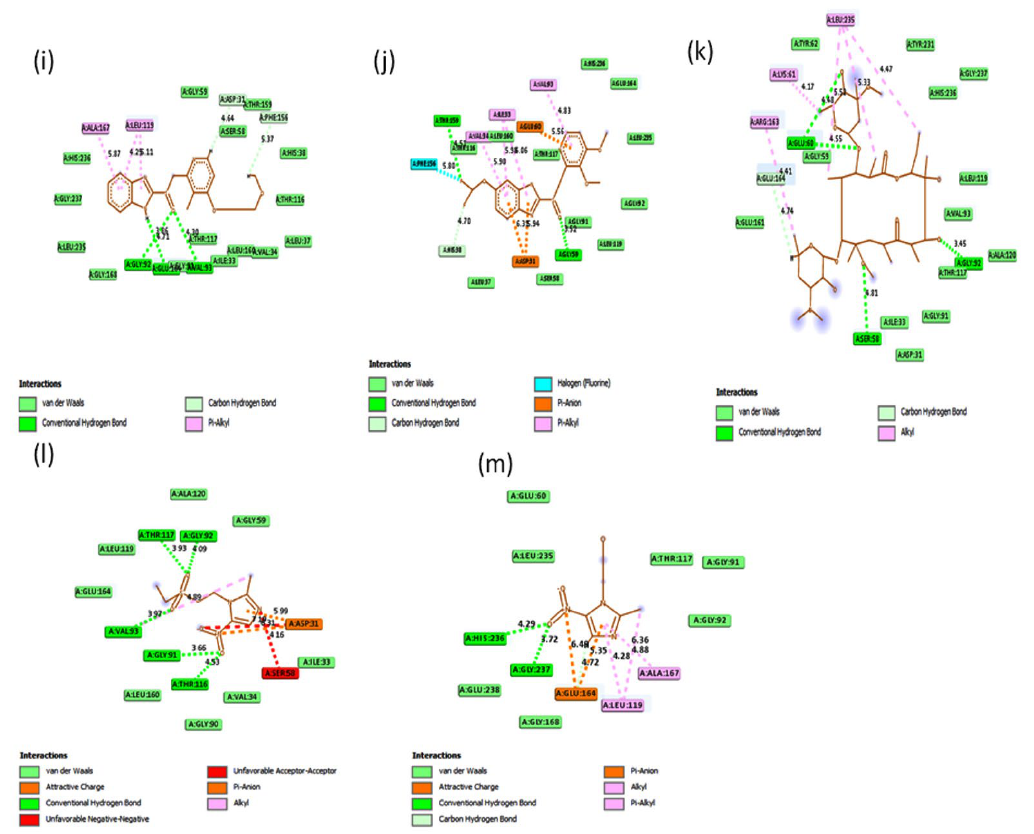
Fig. 2C. 2D interactions of compounds RBP, PPZ, CLA, TIND, and MTZ with chorismate synthase PDB: 1UFM. 2D structures of the candidate drugs (i) Rabeprazole (RBP) (j). Pantoprazole (PPZ). (k) Clarithromycin (CLA). (l) Tinadazole (TIND). (m) Metronidazole